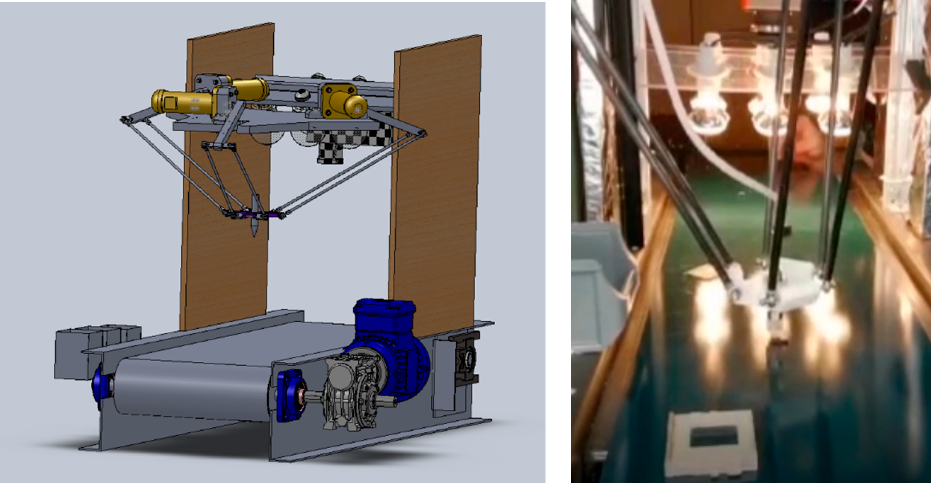
Figure 8. Delta X robotic arm designed in SolidWorks ( left image ); real robot ( right image ).